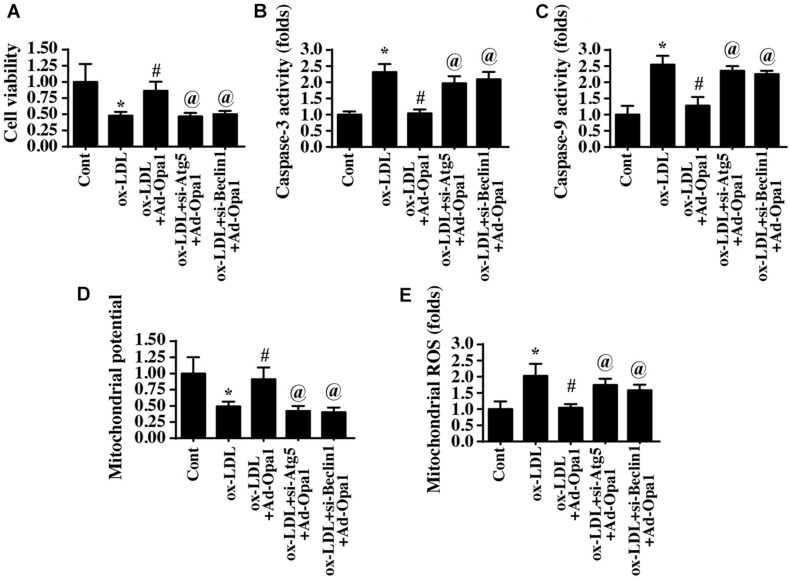
Overexpression of Opa1 restores endothelial cell viability and reduces apoptosis after ox-LDL treatment by modulating mitophagy and mitochondrial fusion. (A) Cell viability was determined through the CCK8 assay. siRNAs against mitophagy (Atg5) and mitochondrial fusion (Mfn2) were transfected into Opa1-overexpressed endothelial cells. (B,C) An ELISA was used to observe the activity of caspase-3 and caspase-9. (D) A JC-1 probe was used to observe the mitochondrial membrane potential in endothelial cells after exposure to ox-LDL. (E) Mitochondrial ROS production in ox-LDL-treated endothelial cells was measured through immunofluorescence. *p < 0.05.